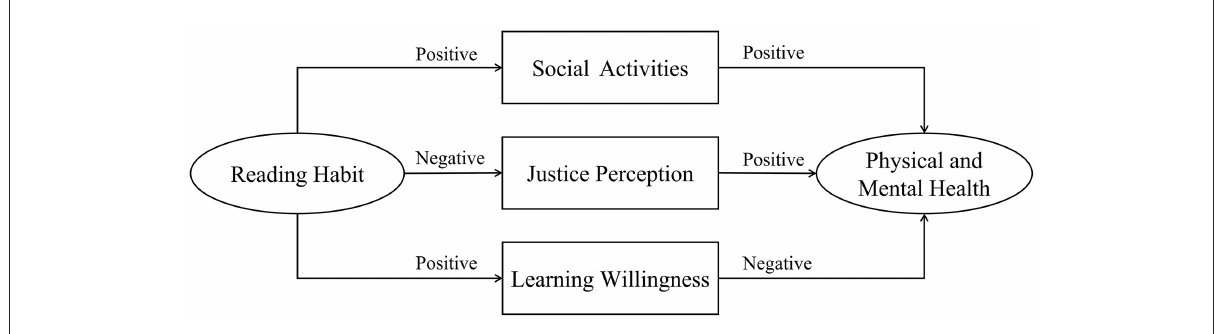
FIGURE1 Mechanism model of the influence of reading habits on physical and mental health of the